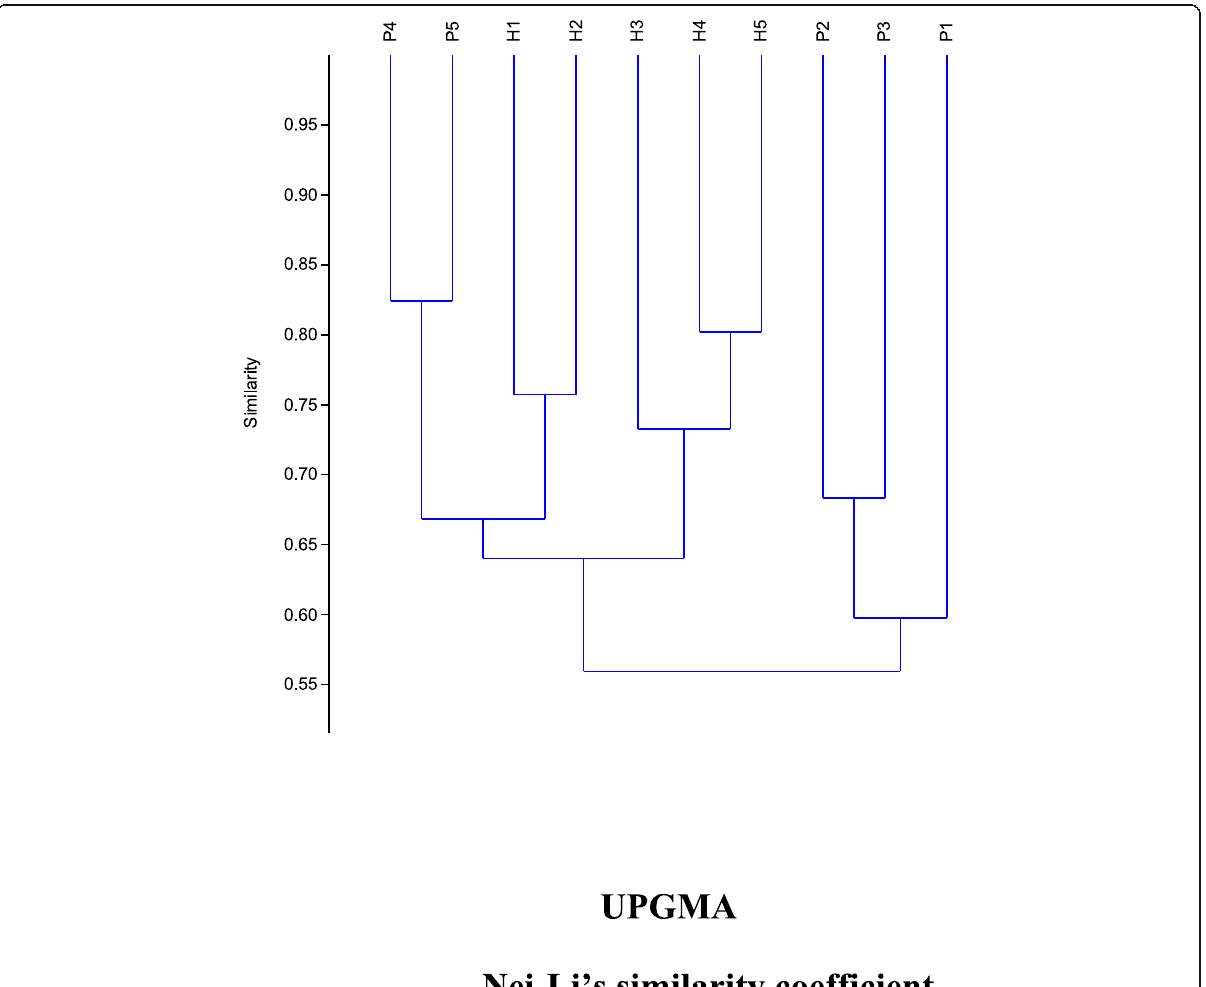
Fig. 2 Dendrogram representing the genetic relationship among the ten wheat genotypes using UPGMA cluster analysis of Nei-Li ’ s similarity coefficient generated from the eight ISSR